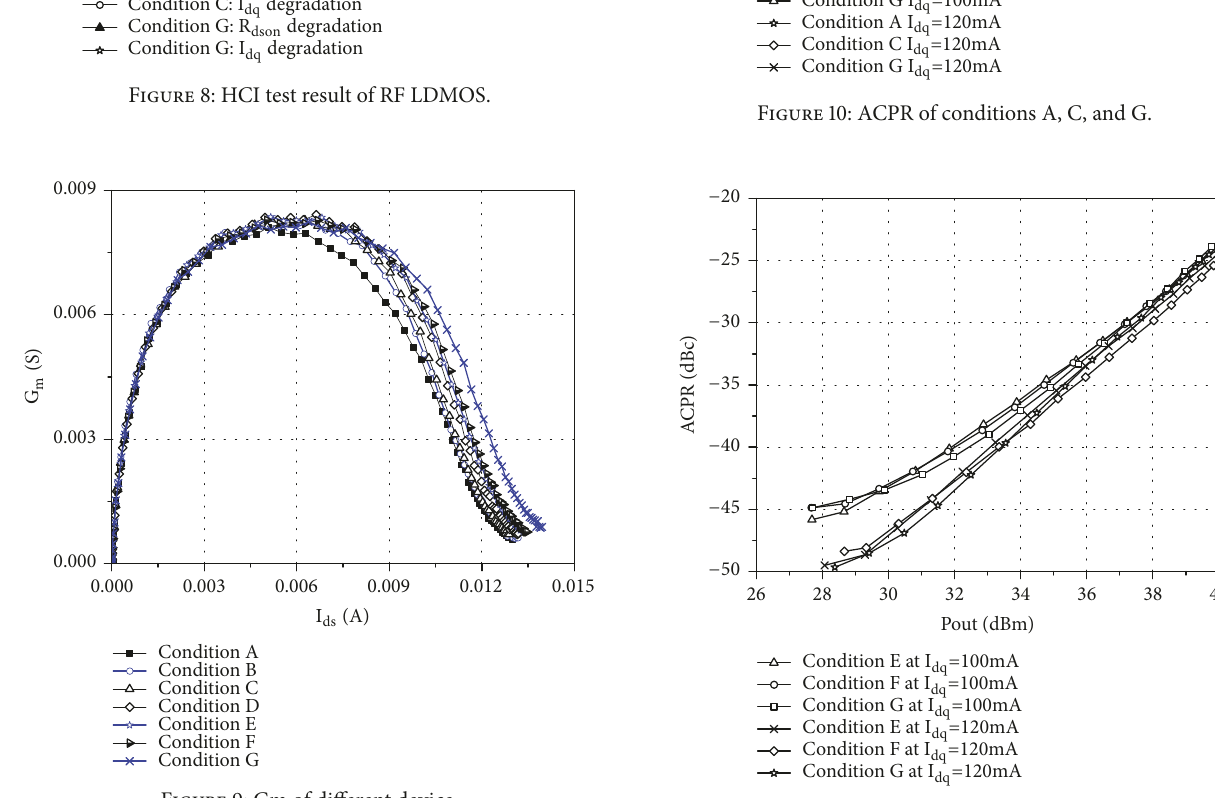
Figure 11: ACPR of device with different